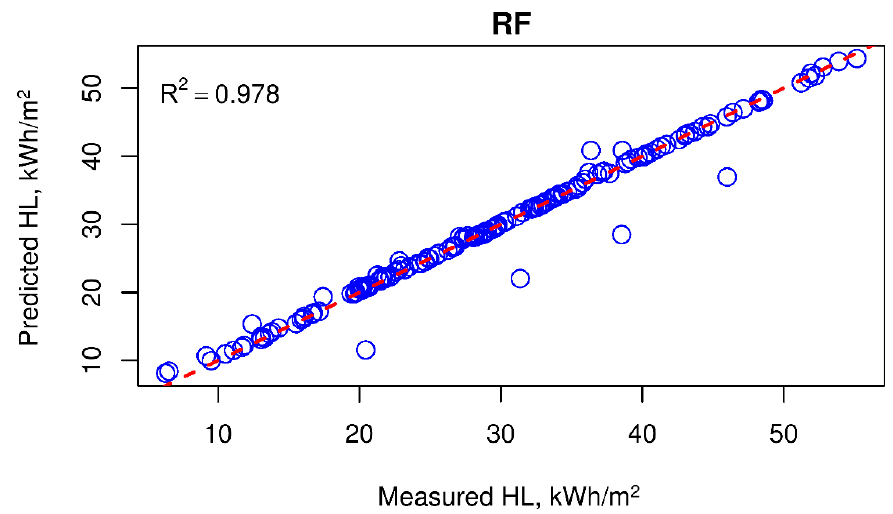
Figure 14. The results of HL prediction from the RF model.